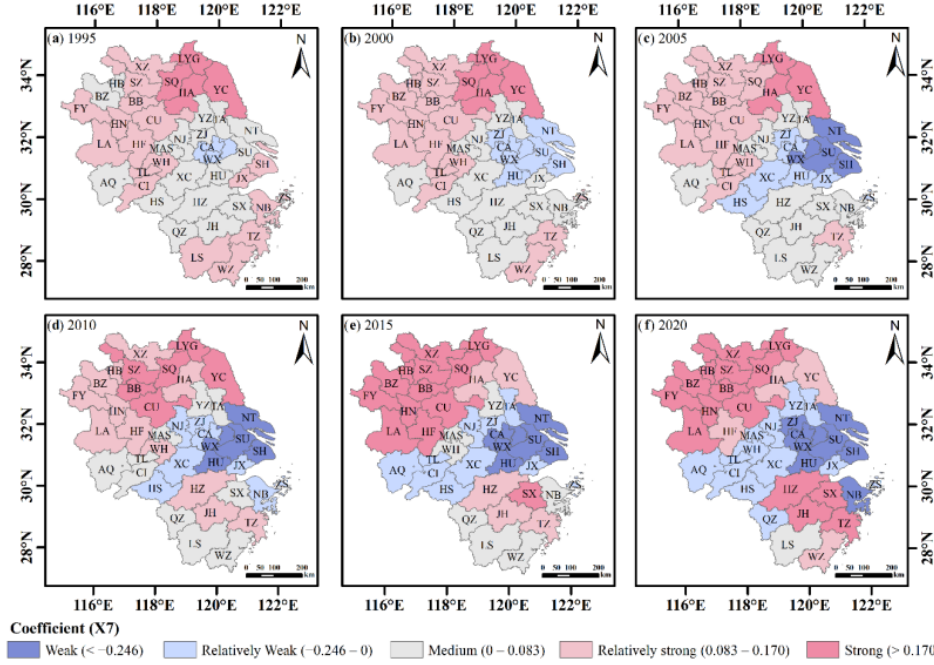
Figure A7. Spatial distribution of the regression coefficients of the urban-rural income ratio.